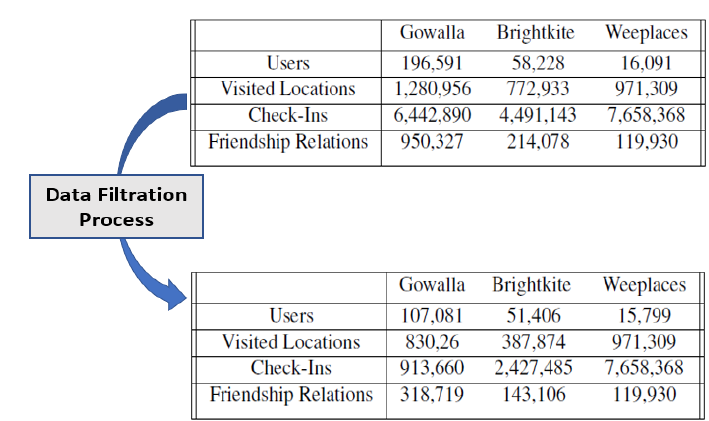
Figure 7. Gowalla, Brightkite, and Weeplaces updated datasets.